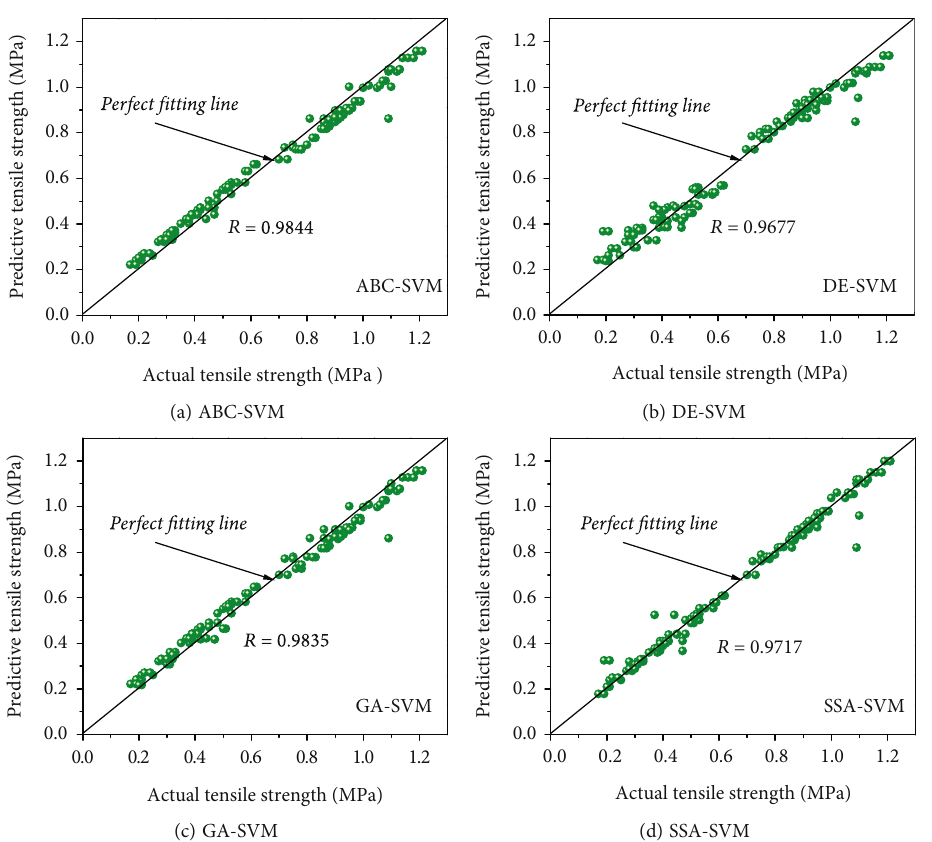
Figure 5: The training e ff ects of di ff erent prediction model for training set.